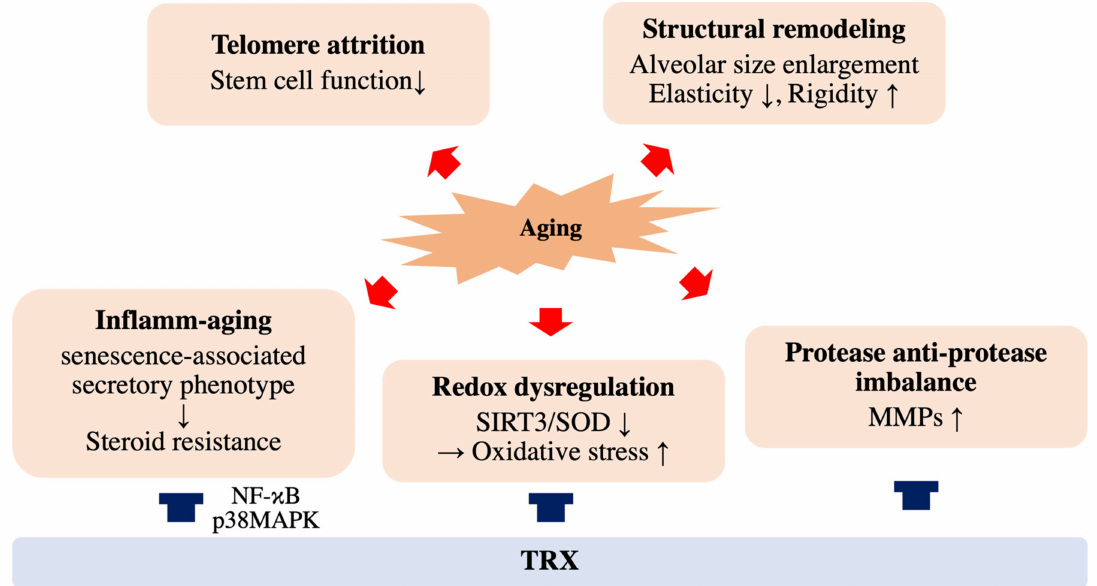
Figure 2. Effects of aging and thioredoxin (TRX) on COPD pathology. Cellular aging accelerates COPD progression through structural remodeling, telomere attrition, inflammatory aging, redox dysregulation and protease and anti-protease imbalance. TRX has therapeutic potential for COPD by improving phenomena such as inflamm-aging and redox